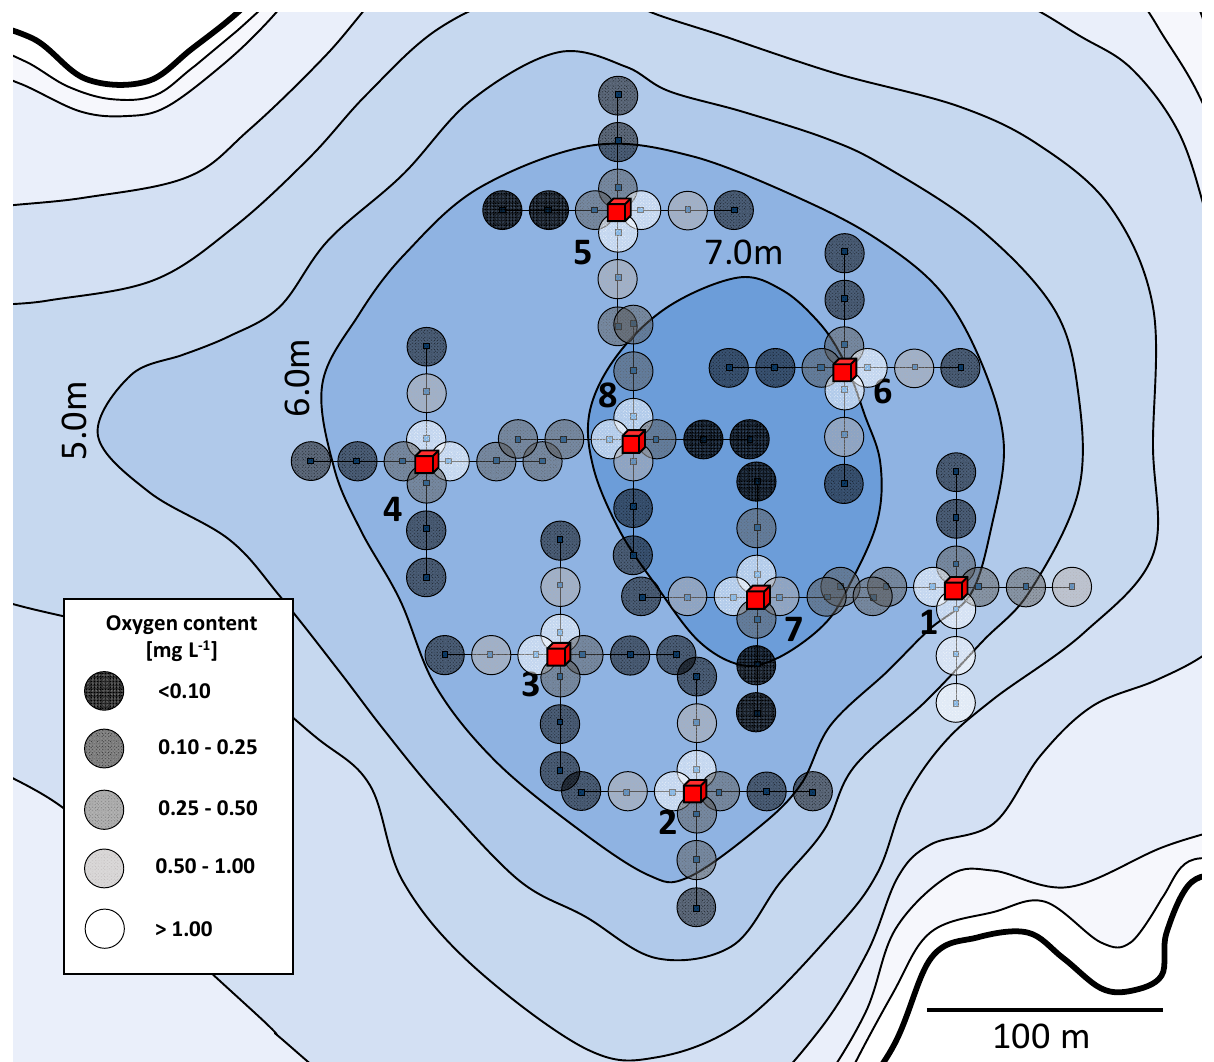
Figure 5. Oxygen content around the application devices, in the near-bottom water (0.5 m above the sediment).